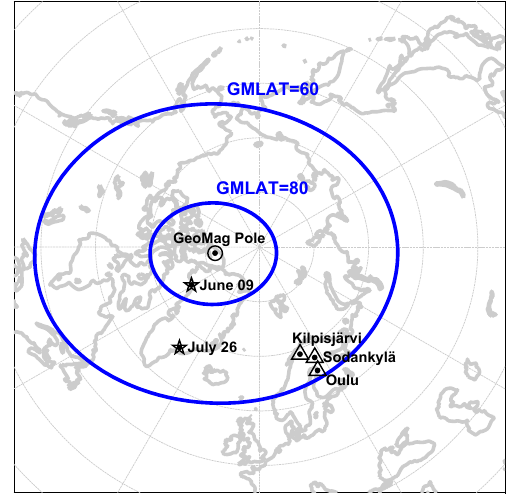
Fig. 1. A map showing position of the auroral zone in the North- ern Hemisphere. Stations with co-located seismic and magnetic instruments considered in the present study are shown by trian- gles. Stars marked as 9 June and 26 July indicate epicentres of glacial earthquakes on 9 June and 26 July 2007 from Nettless and Ekstr¨om